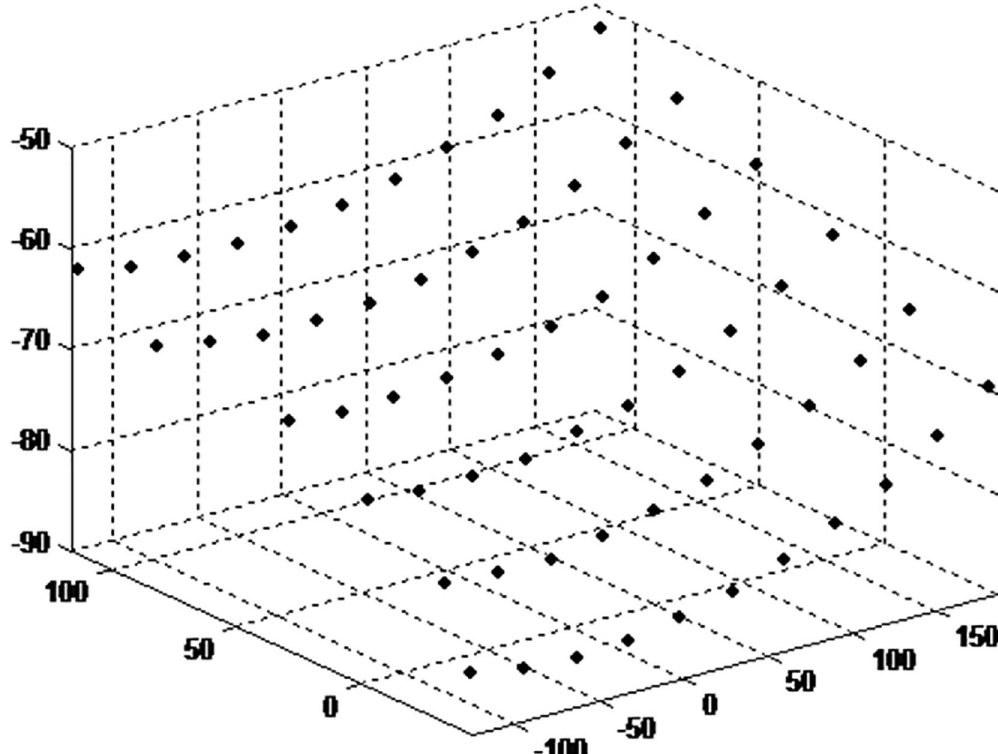
Fig 14. retrieval results based on Zhang’s